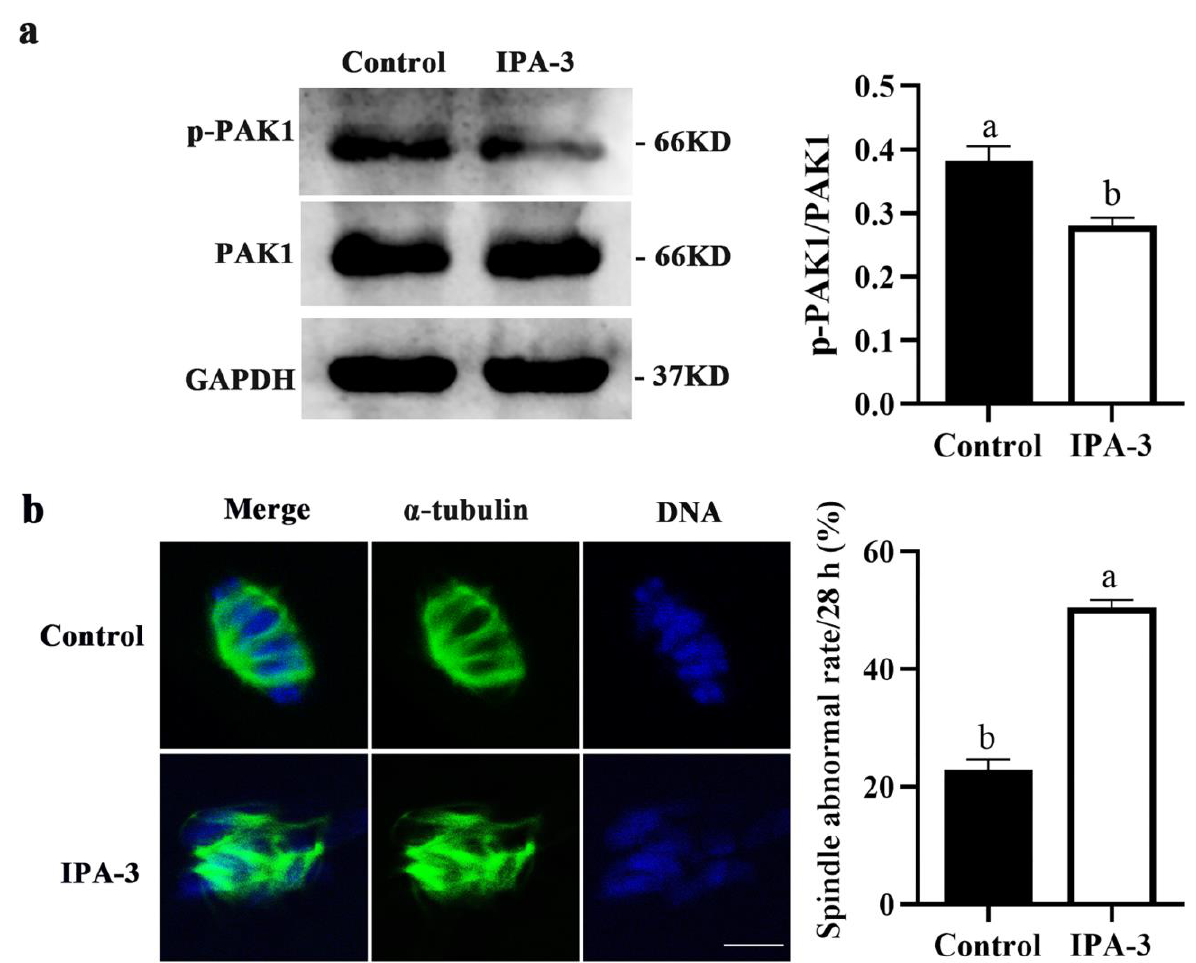
Figure 3. Effects of IPA-3 treatment on spindle assembly during the first meiotic division in porcine oocytes. ( a ) Effect of IPA-3 treatment on the expression of p-PAK1 after 28 h of culture. ( b ) Effect of PAK1 inhibition on the spindle morphology and chromosome alignment in porcine oocytes ( n = 100 for the control group; n = 101 for 30 µM IPA-3 group). Green, α-tubulin. Blue, chromosome. Scale bars are 10 μm. a, b Values with different superscript letters above columns indicate significant differences ( p < 0.05).